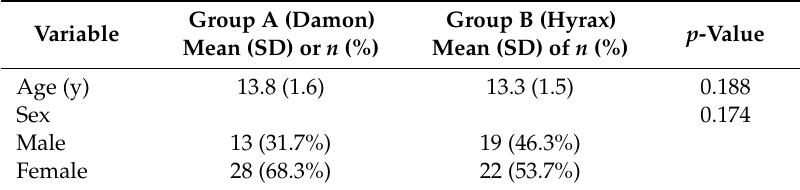
Table 1. Demographic characteristics of the